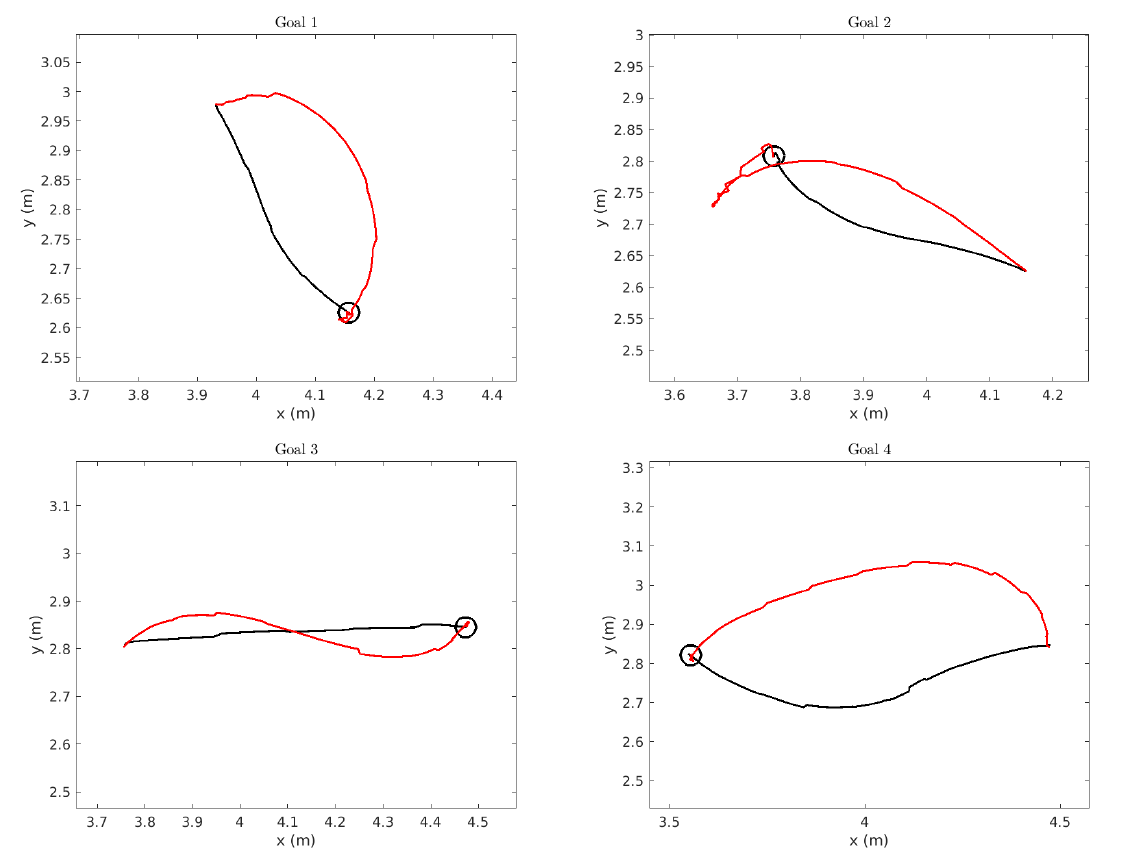
Figure 13. Trajectories taken by the robot for each goal. The goal is denoted by the black circle. The position of the robot using the MSDU Local Planner is displayed in black, and the robot position by the TEB Local Planner is displayed in red. Note that discrepancy in the curves are due to the localization